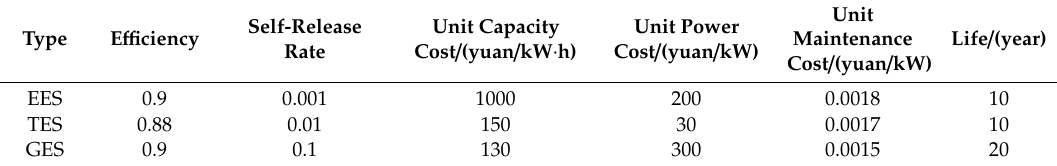
Table 2. The decision vector